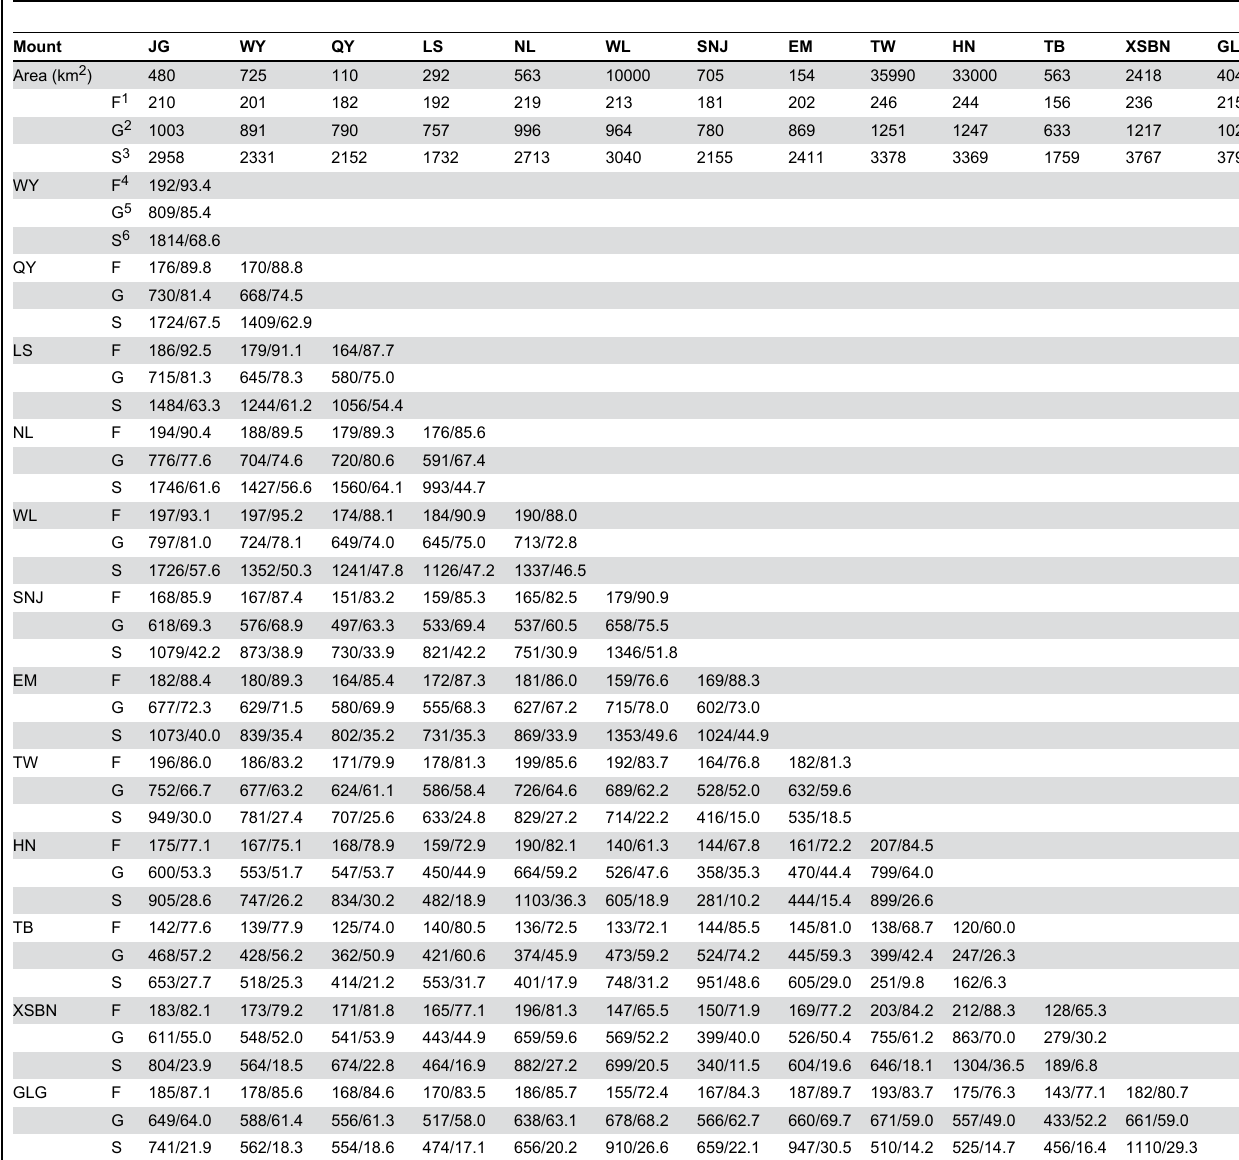
Table 12. Similarity coefficients at family, genus and species between Mount Jinggangshan region and other twelve main mounts in